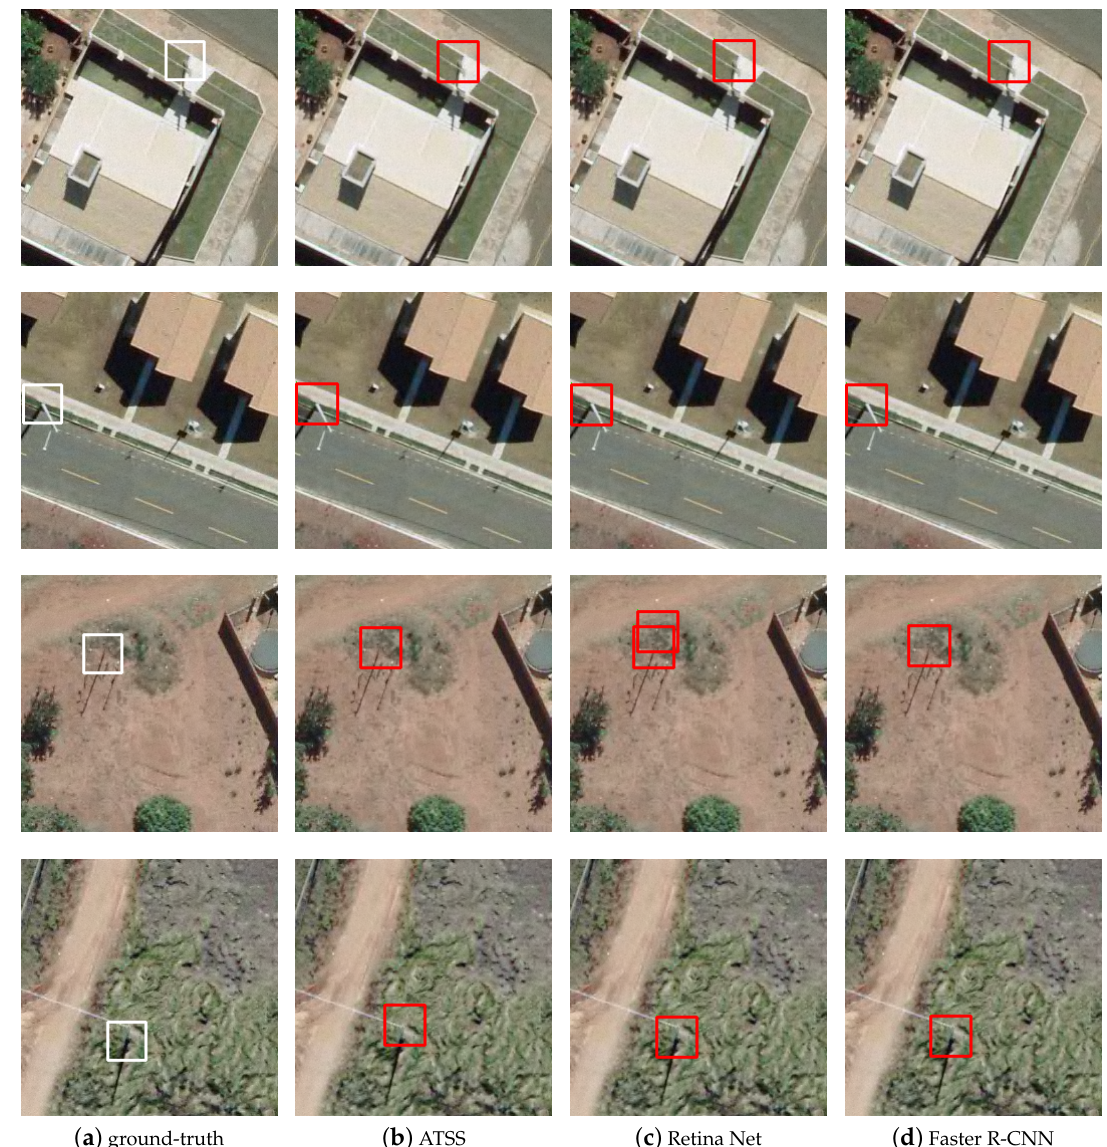
Figure 8. Examples of images with utility poles in different types of terrain: ( a ) ground-truth; ( b ) ATSS; ( c ) RetinaNet; and ( d ) Faster